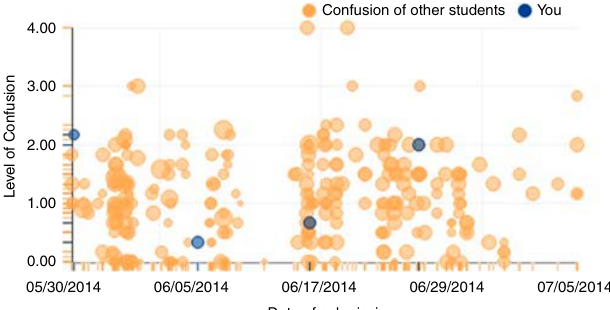
Figure 4. Scatterplot visualization showing the relation between the emotion frequency and work dedication along